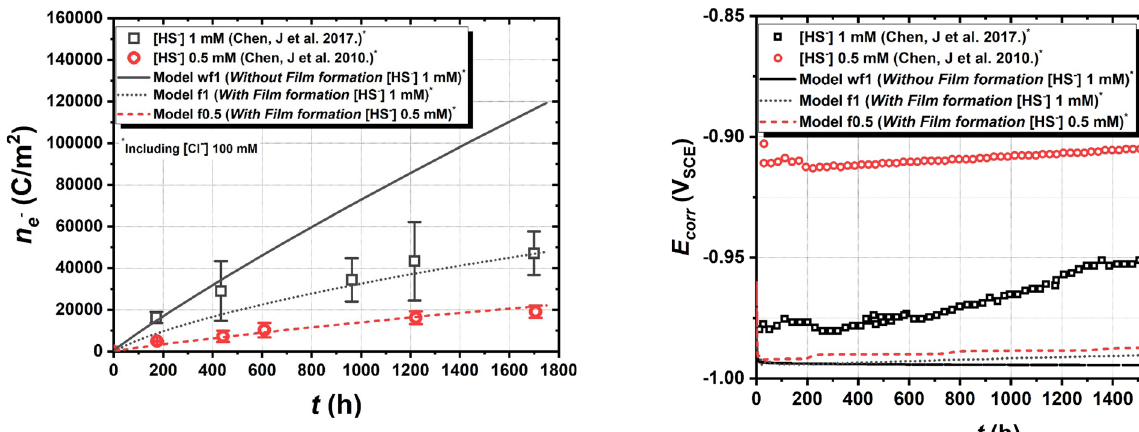
Fig. 4 Validation for simulated amounts of corroded Cu. Comparison of data experimentally measured by Chen et al. (2010 and 2017) and numerically simulated in this study corroded amounts of Cu in terms of number of electrons per unit area ( n e- ) for Cu immersed in 0.1 M Cl − with 1 mM HS − and 0.5 mM HS − solutions 29,30 .